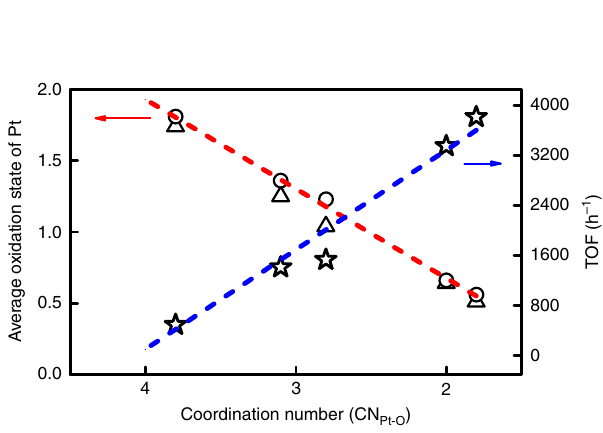
Fig. 4 The correlation between coordination structure and catalytic performance. The star, triangle, and circle represent TOF, average oxidation state of Pt determined from XPS and XANES, respectively. Linear correlations are obtained between the CN of Pt-O and the average oxidation state (red line), and between CN of Pt-O and the hydrogenation activity (blue